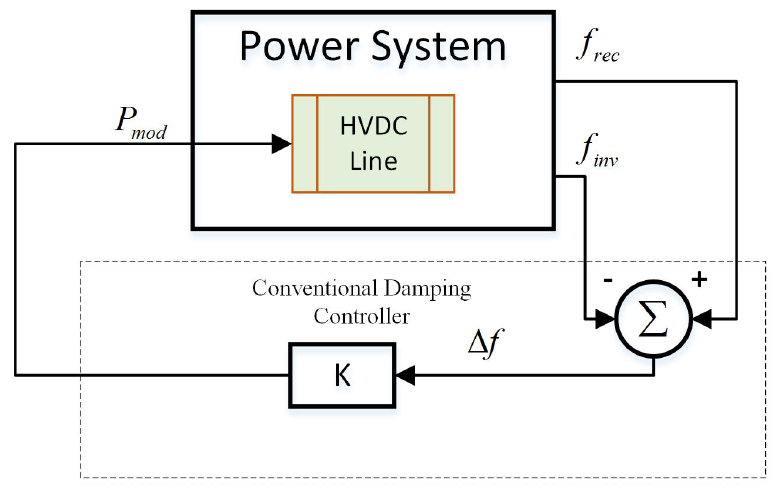
Figure 2. Typical Conventional HVDC damping controller based on the frequency